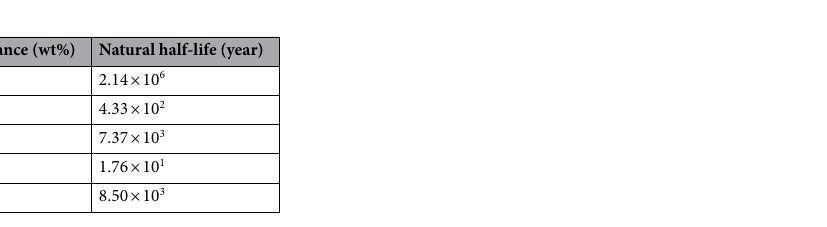
Table 3. Isotope abundance and half-life of loaded MAs